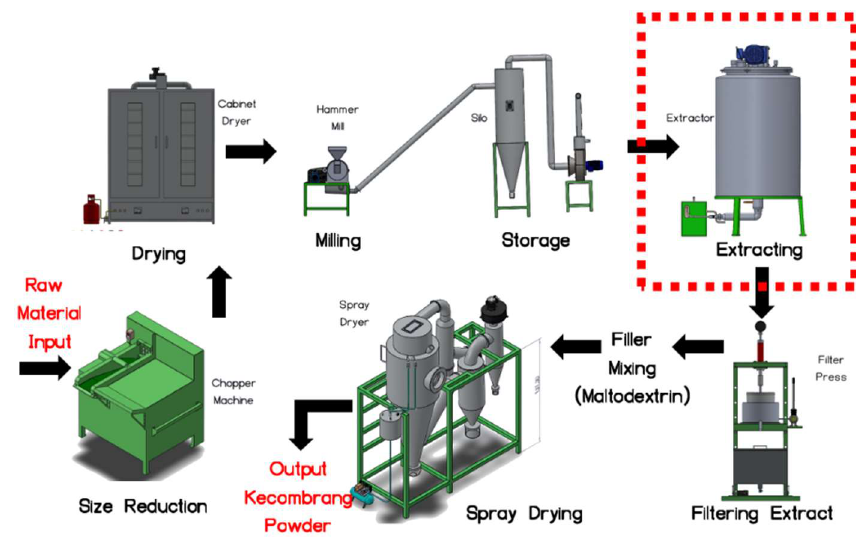
Figure 1. Design of the kecombrang processing